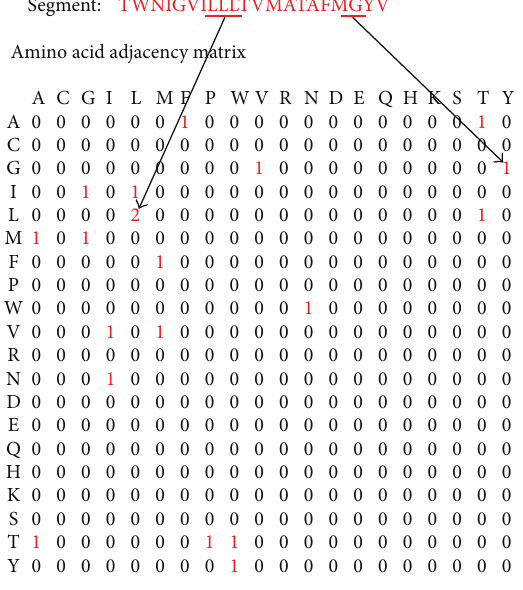
Figure 1: Amino acid adjacency matrix. The 20 × 20 matrix presenting the amino acid adjacency and abundance information in the given sequence. The nonzero elements show the number of times that corresponding amino acids are present adjacent to each other. The 20-dimensional row sum vector is used as a descriptor to numerically characterize the protein